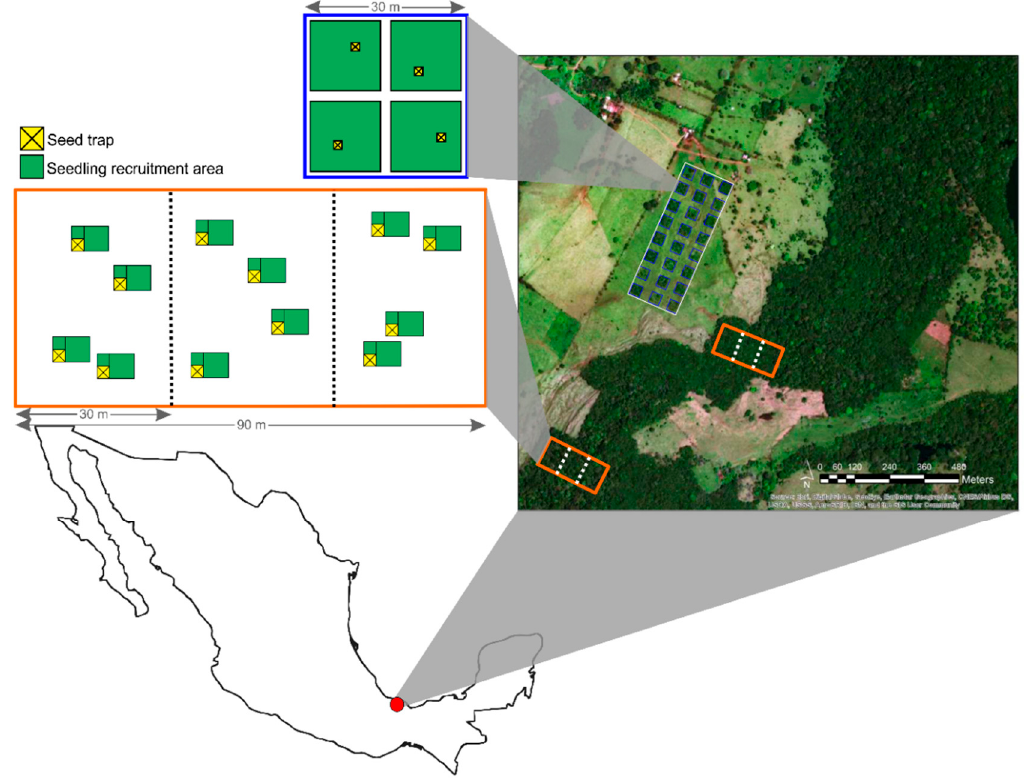
Figure 1. Study site and experimental design used to collect seed and seedling data in Los Tuxtlas, Mexico. The aerial photo shows the distribution of the primary forest, the secondary forest and the pasture sites. The two schemes in the top left show the sampling design with 1 m 2 seed traps and the area where seedling recruitment was measured.